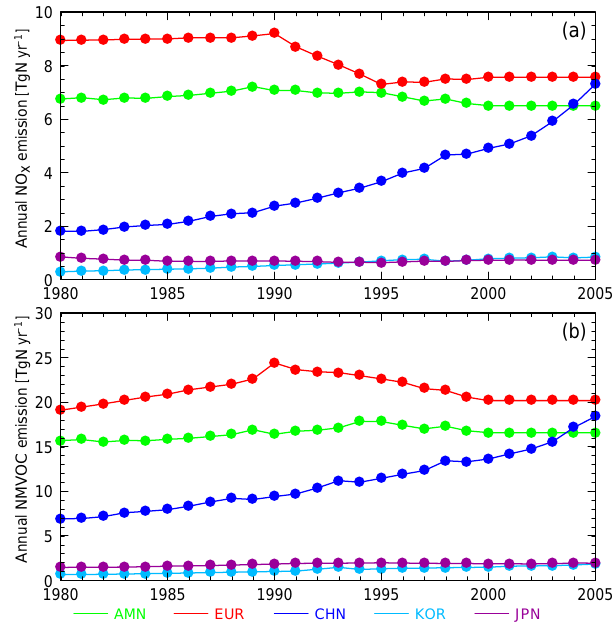
Figure 2. Temporal evolution of emissions of (a) NO x and (b) NMVOC averaged over several source areas in the Northern Hemisphere depicted in Fig.